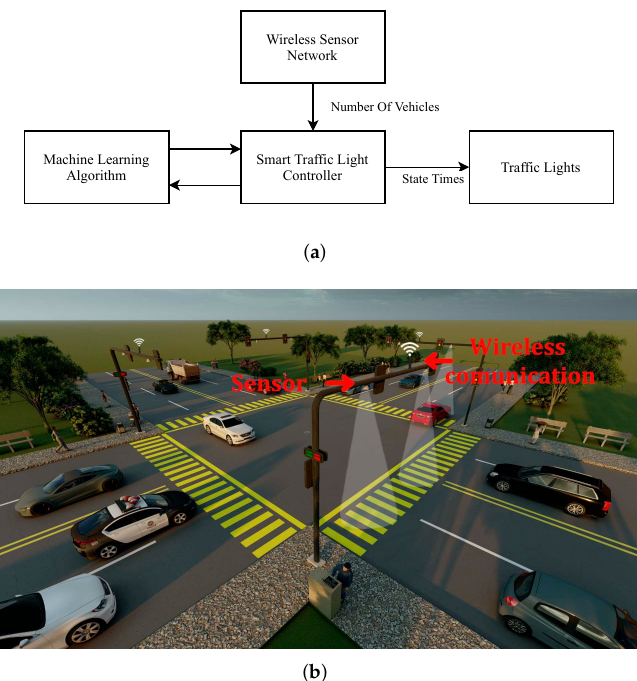
Figure 8. Proposed usage. ( a ) Block diagram; ( b ) Representation in real-world